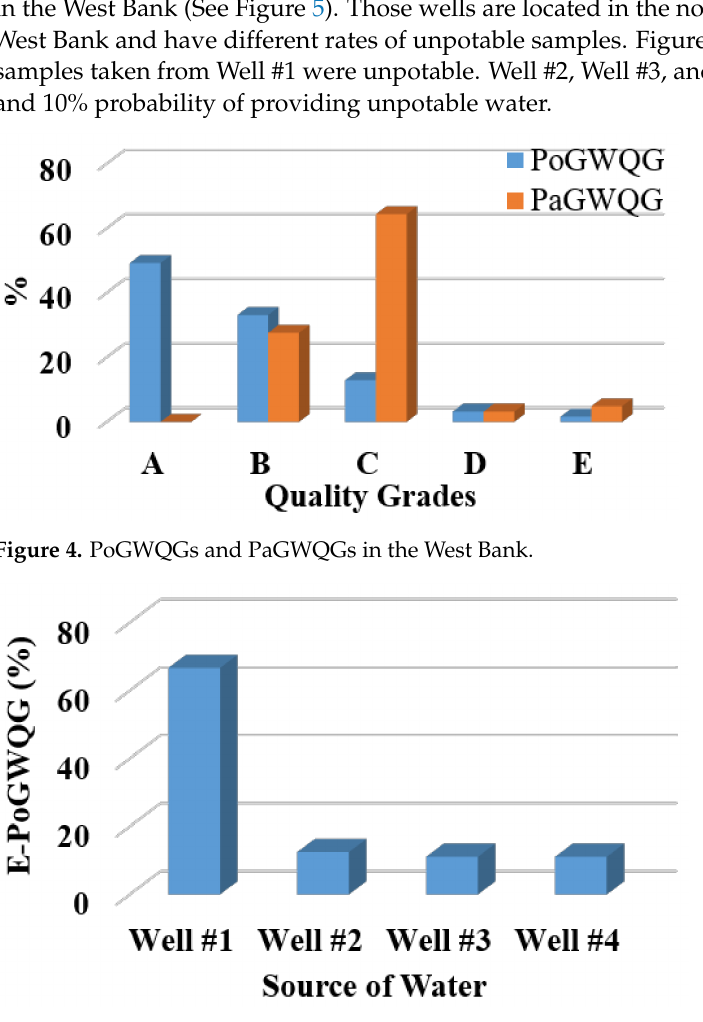
Figure 5. Un-potability rate over four contaminated groundwater wells in the West